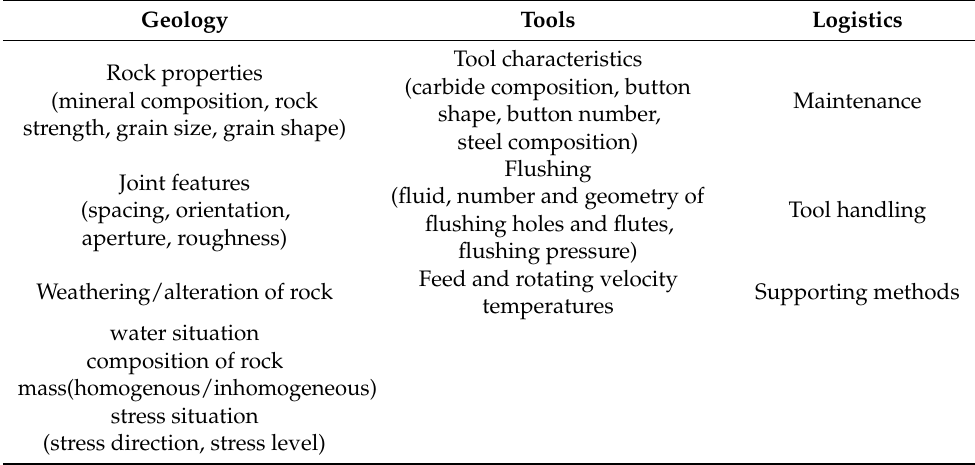
Table 1. Summary of the main factors influencing cutting tool life and wear